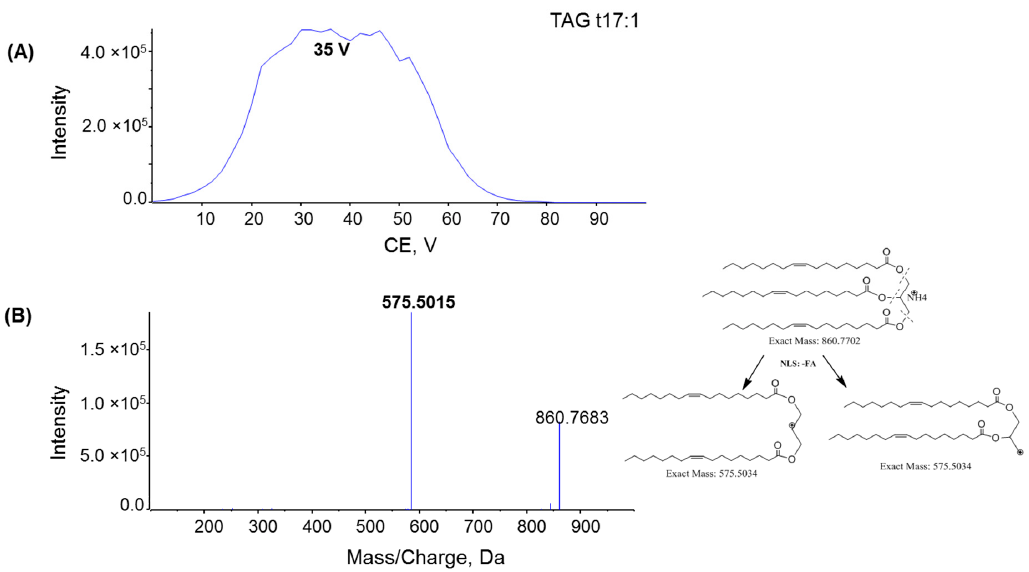
Figure 6. ( A ) Plot intensity of fragment m / z 325.2742 of DAG d17:1 with varying rolling collision energy (CE); ( B ) MS/MS spectra for DAG d17:1 with CE = 32 V; insert: the fragmentation pathway of DAG d17:1 via ESI tandem MS. Spectra were acquired under the following conditions: GS1 = 10, GS2 = 10, CUR = 15, Temp = 300 °C, DP = 100 V, CE = 32 V.